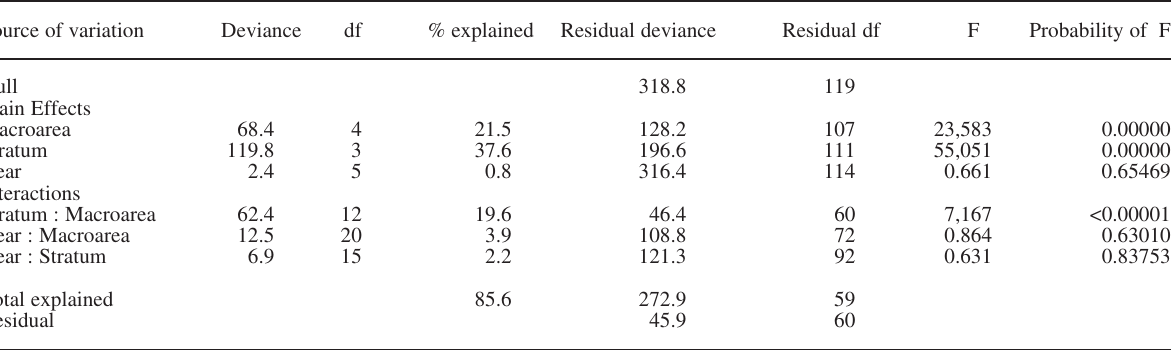
T ABLE 7. – Lepidorhombus boscii : analysis of deviance table for generalised linear models fitted to MEDITS biomass indices (g/km 2 ) obtained in the years 1994-1999. Source of